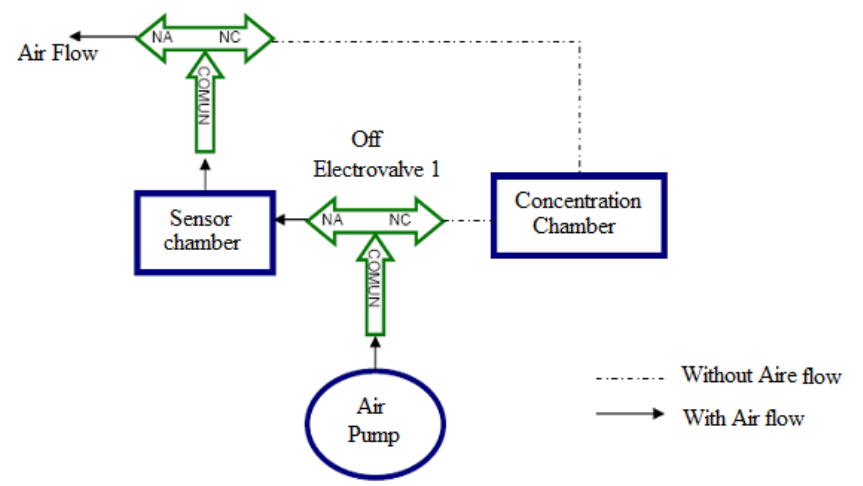
Figure 2. Diagram of air flow in the concentration and purge